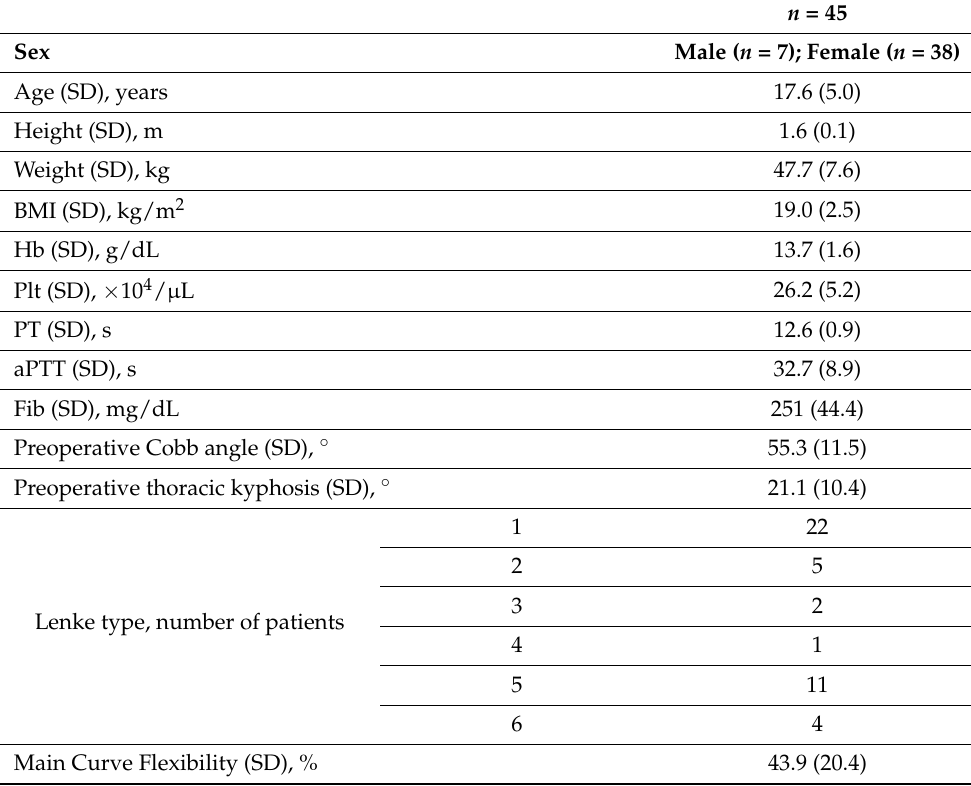
Table 1. Preoperative Demographic Data and Lenke Classification.